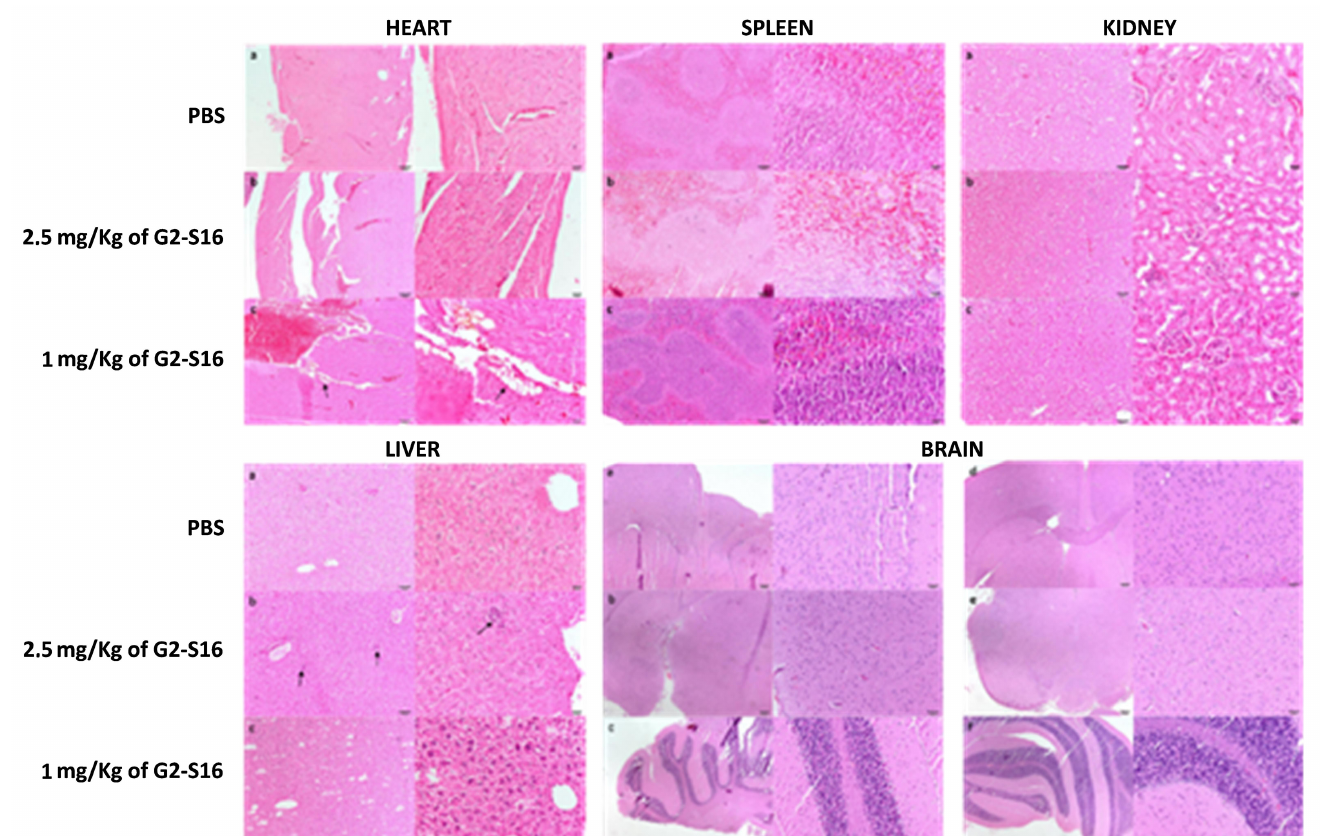
Figure 7. G2-S16 dendrimer causes no histological lesions in analyzed organs. Hearts from mice treated with PBS, 2.5 mg/kg of G2-S16 dendrimer or 1 mg/kg G2-S16 dendrimer were analyzed, and no relevant histological lesions were found in any of the samples, although the presence of adipocytes (arrows) in endocardium and myocardium were observed. Spleens and Kidneys from mice treated with PBS, 2.5 mg/kg of G2-S16 dendrimer or 1 mg/kg G2-S16 dendrimer were analyzed, and no histological lesions were found in any of the samples. Livers from mice treated with PBS, 2.5 mg/kg of G2-S16 dendrimer or 1 mg/kg G2-S16 dendrimer were analyzed. Although minimal histological lesions were found in some of the samples, including multifocal inflammatory infiltrates (arrows) and vacuolar degeneration, there was no significant difference between the PBS and the G2-S16 dendrimer-treated groups. Brains from mice treated with PBS, 2.5 mg/kg of G2-S16 dendrimer or 1 mg/kg G2-S16 dendrimer (images not shown) were analyzed, and no histological lesions were found in any of the samples. Images were obtained from midbrain, thalamus and cerebellum. The images on the right are zoom-ins at the images on the